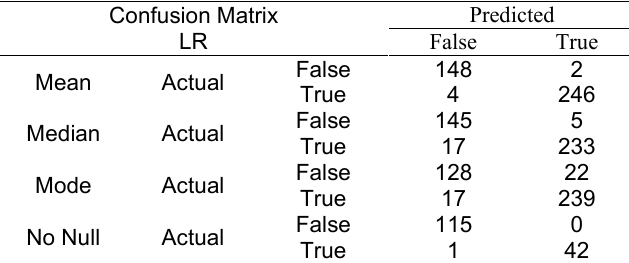
Table 3. Confusion Matrix for Logistic Regression